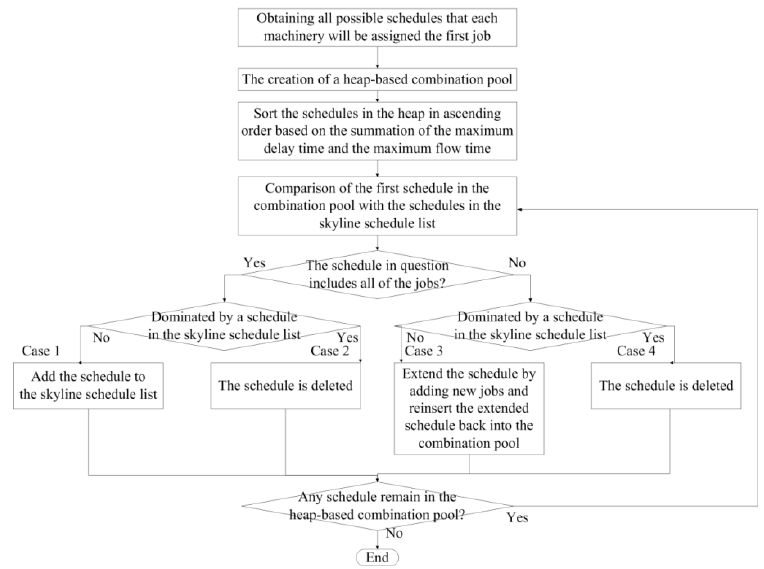
Figure 6. Chart of the proposed scheduling algorithm. Table 3. Example results obtained from the first step of the proposed scheduling algorithm.